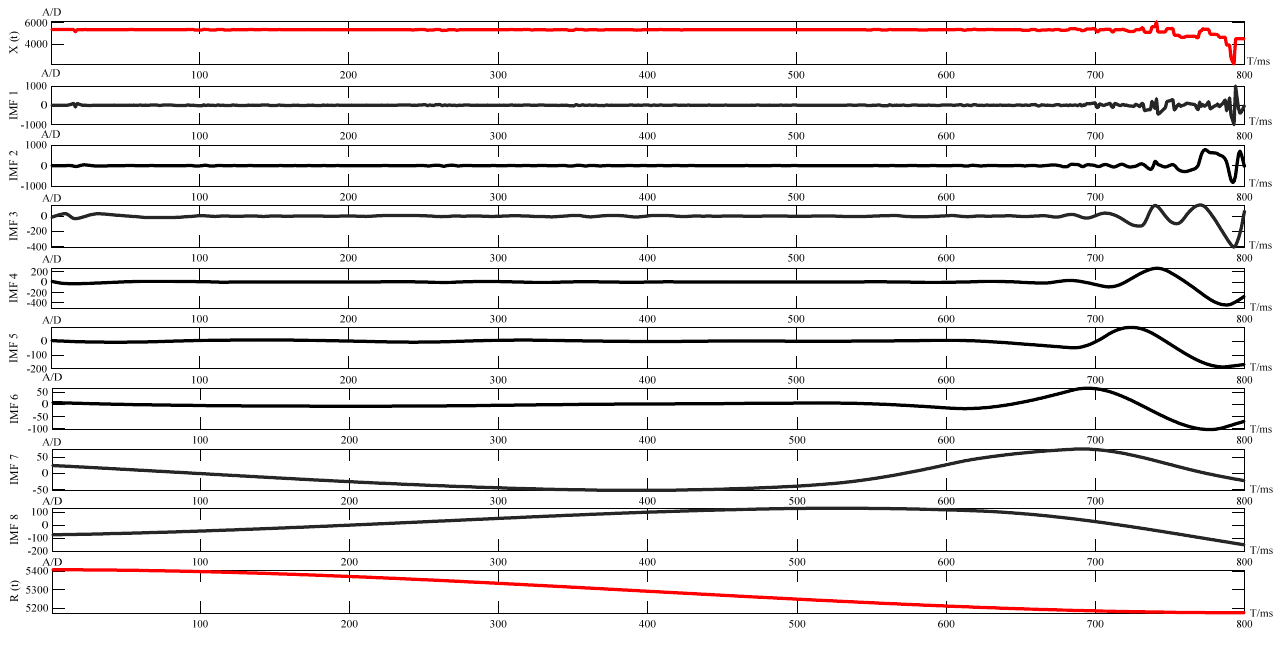
Figure 12. The decomposition diagram of EMD.